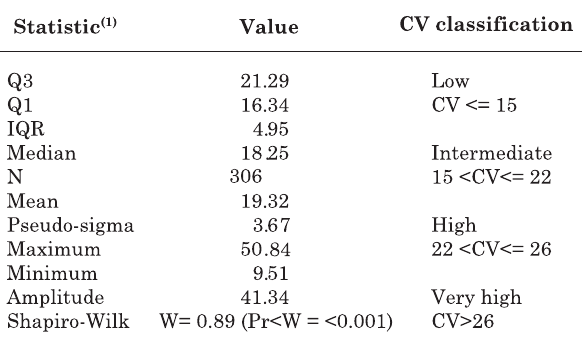
Table 2. Statistics and classification of the PR coefficients of